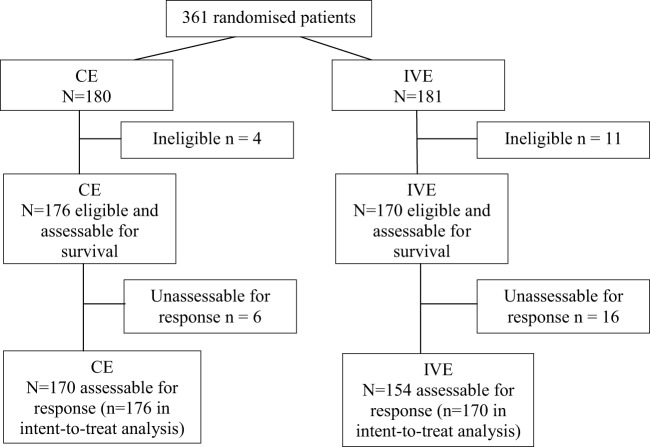
Consort diagram.